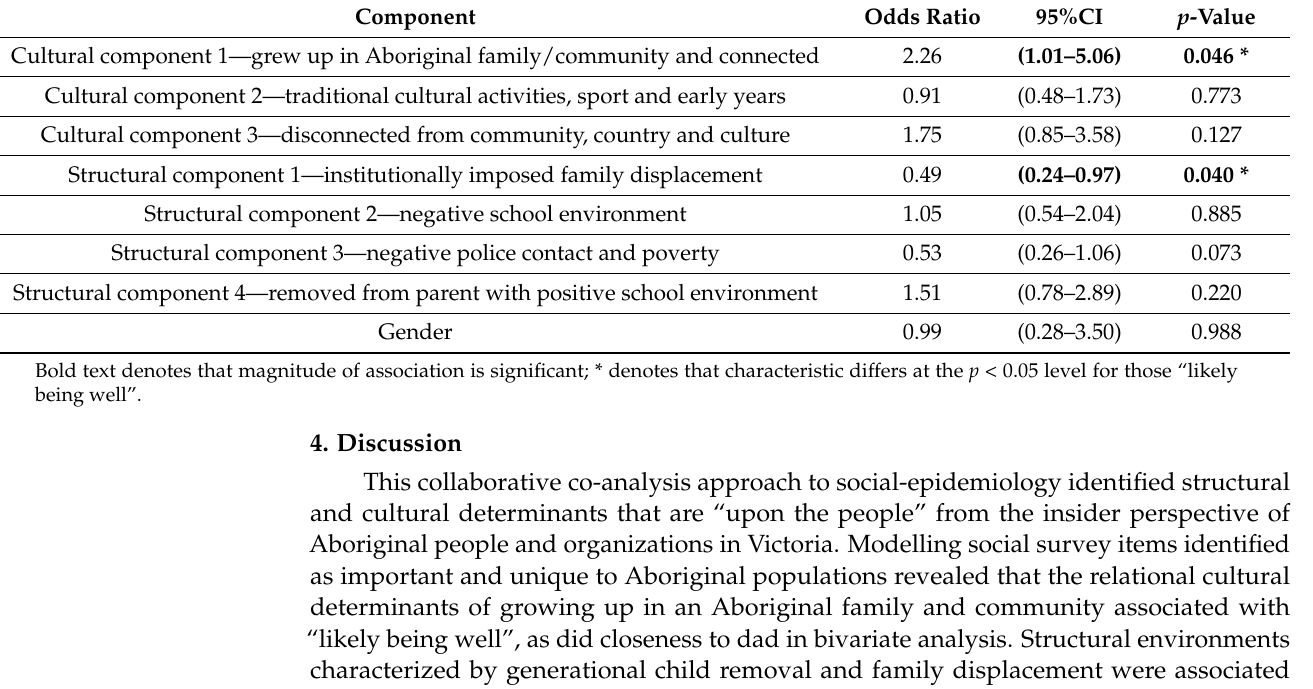
Table 5. Odds ratio of “likely being well” associated with components from PCA for Aboriginal adolescents from Victoria. Component Odds Ratio